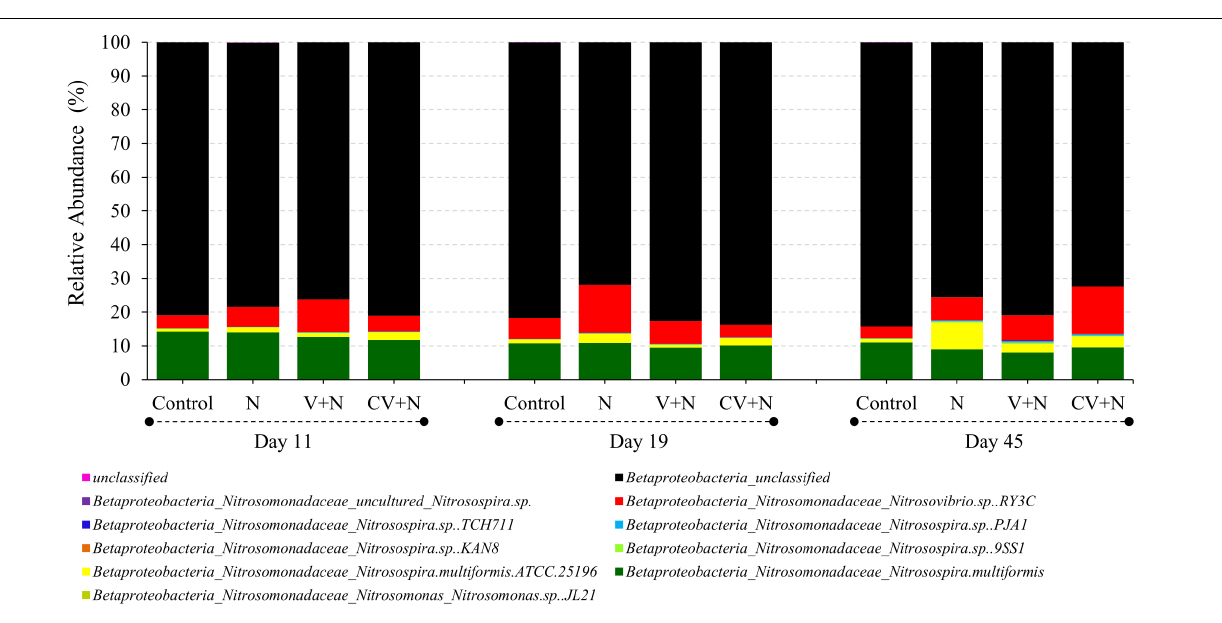
FIGURE 2 | Average relative abundances of the AOB community ( n = 36) at the level of species. The sequencing reads of amoA -AOB genes were assigned to their taxonomic affiliations of nitrifying bacteria that oxidize ammonia, by comparison to the amoA database in